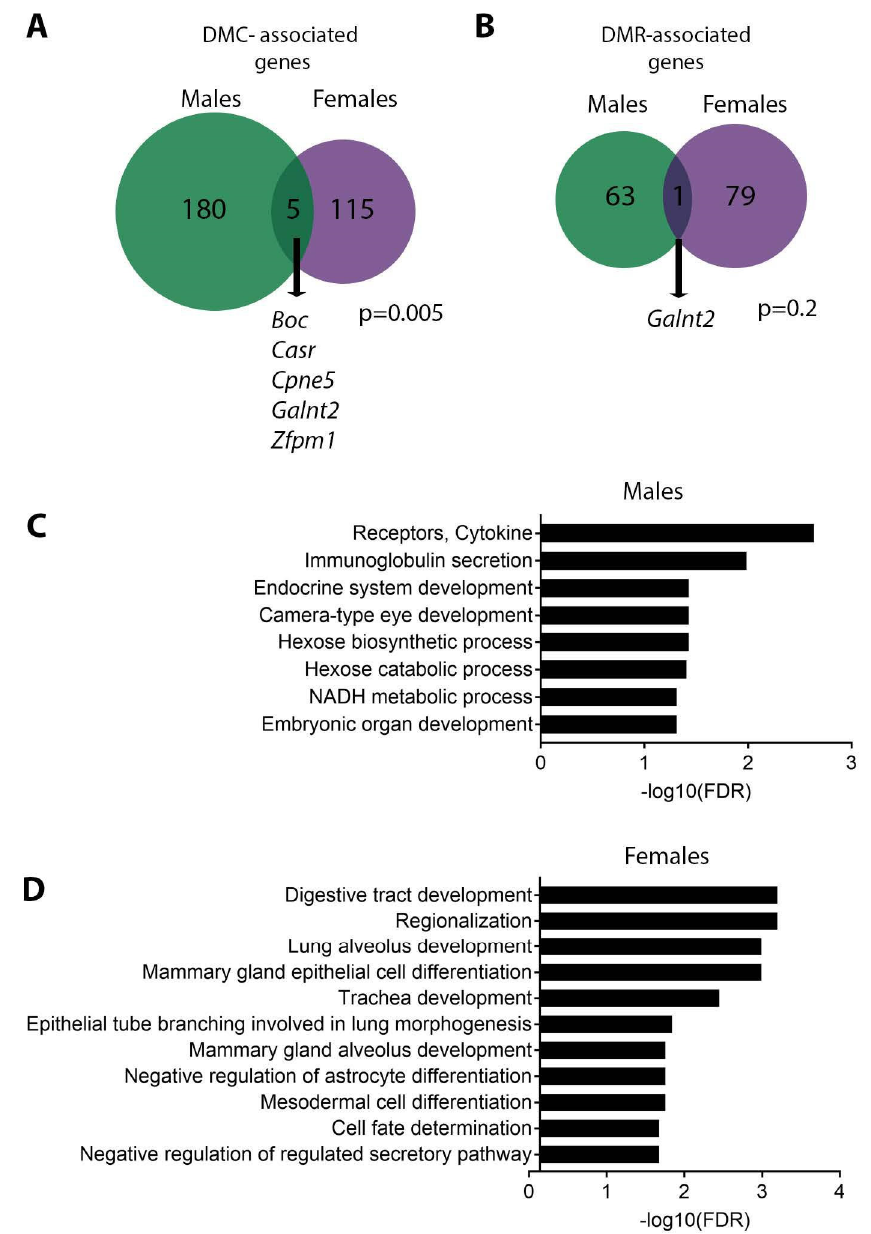
Figure 5. Sex specificity of Pb-induced changes in DNA methylation. ( A , B ) Venn diagrams depicting overlap between males and females in DMC-associated genes ( A ) or DMR-associated genes ( B ). p -values for overlap between the two groups calculated using a hypergeometric test. Overlap between sexes in DMC-associated genes was significant. ( C , D ) Polyenrich pathway analysis for DMCs in males ( C ) and females ( D ).